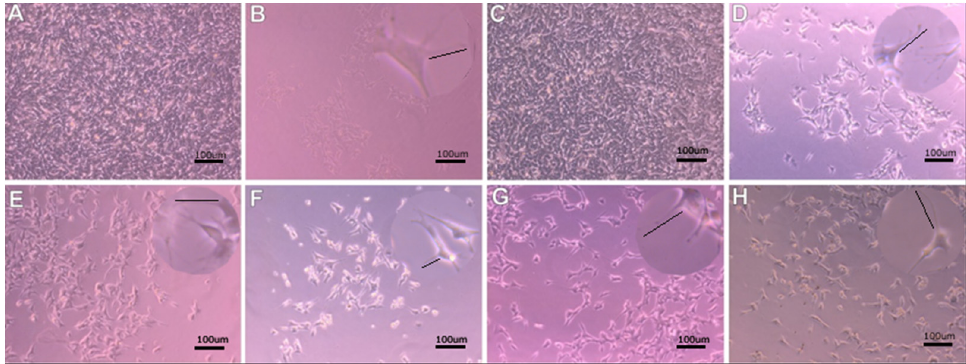
Figure 3. Vibration with a frequency of 40 Hz. ( A ) PM non-collagen—40 Hz, ( B ) PM non-collagen—control, ( C ) PM collagen—40 Hz, ( D ) PM collagen—control, ( E ) DM non-collagen—40 Hz, ( F ) DM non-collagen—control, ( G ) DM collagen—40 Hz, ( H ) DM collagen—control. In the upper right corner, zoom in to show neurites.